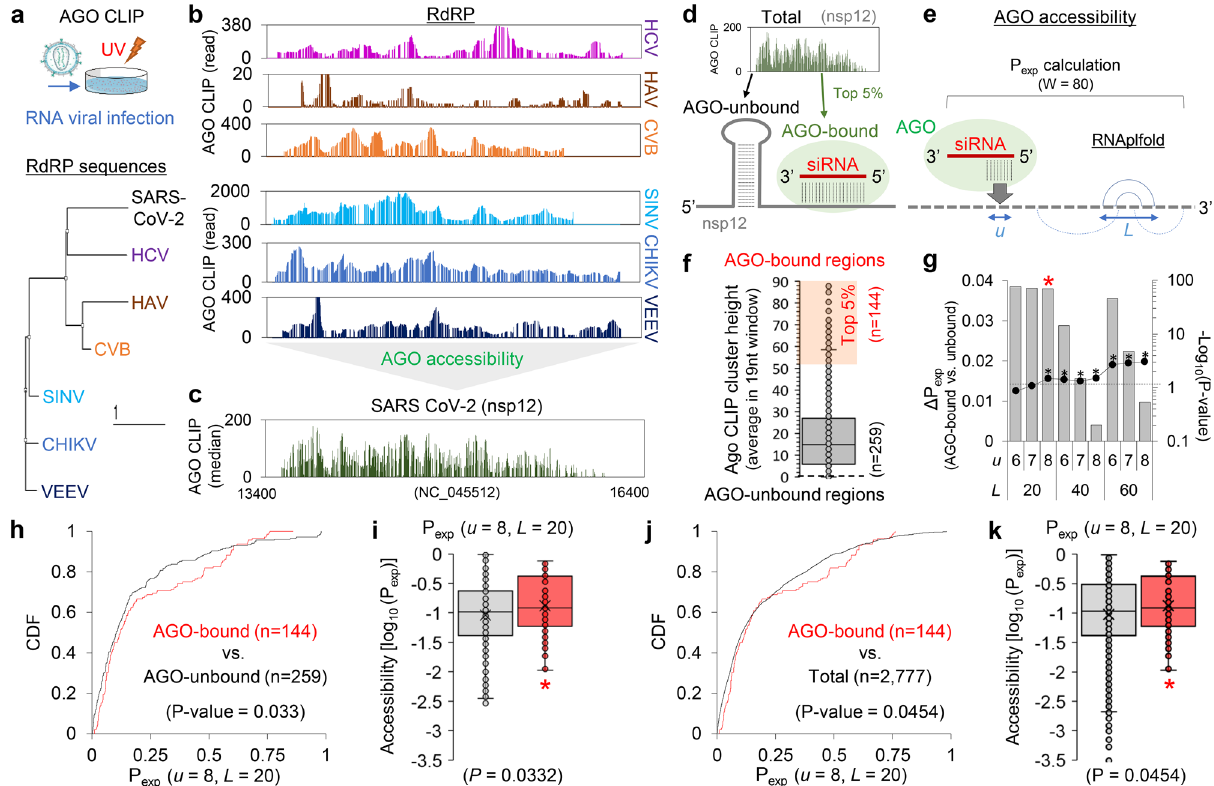
Figure 1. Meta-analyses of AGO CLIP data for SARS-CoV-2 and resultant determination of parameters for calculating AGO accessible regions. ( a ) AGO CLIP analyses derived from various RNA viral infections (upper panel), where published data 29 from standard AGO CLIP were retrieved. Six RNA viruses were selected as related to SARS-CoV-2 based on phylogenic analyses of RdRP sequences (lower panel). Details in the Material and methods section, providing accession numbers in the GEO database. ( b ) AGO-bound regions in the RdRP of the six RNA viruses related to SARS-CoV-2, aligned on the counterpart region of the nsp12 in SARS-CoV-2; HCV, HAV, and CVB ( b , upper panel) and SINV, CHIKV, and VEEV ( b , lower panel) ( c ) Consensus AGO CLIP reads on the nsp12 of SARS-CoV-2 (NC_045512), delineated from the meta-analysis. Compiled AGO CLIP reads (median of read-counts at each position) are presented to estimate putative AGO binding in the nsp12 region of SARS-CoV-2, inferred from the six RNA viruses 29 . ( d,e ) Schematics for predicting AGO accessibility; AGO-bound (top 5%) and AGO-unbound (no CLIP reads) regions presumably caused by RNA secondary structure ( d ); calculation of AGO accessibility (P exp ; exposure probability) using the previously defined window size (80 nucleotides; W = 80) under the parameters 31 , length of a region for accessibility ( u ) and range of nucleotides allowing local base pairing ( L ). ( f ) Ranking of the inferred AGO-accessible sites in nsp12. A set of high confident AGO-bound regions (high AGO accessibility) was defined by selecting the top 5% of compiled AGO CLIP clusters depending on their heights (average read-count in the 19 nucleotides window; n = 144, orange shade). AGO-unbound regions were selected as the sites with no AGO CLIP reads across the selected RNA viruses (HCV, HAV, CVB, SINK, CHIKV, and VEEV) or where AGO CLIP reads were observed in only one RNA virus species (biological complexity = 1; n = 259). ( g ) The partition function for all local structures within the window (80 nucleotides) was calculated to derive the exposure probability (P exp ) with RNAplfold 31 . The difference in P exp between the AGO-bound regions and AGO-unbound regions in nsp12 was calculated (ΔP exp , bar graph); significance, − log 10 ( P -value), line graph; dotted-line, P = 0.05; P -value, Wilcoxon rank-sum test (two-sided). ( h ) Cumulative distribution function (CDF) analyses of P exp under the optimised parameter ( u = 8, L = 20) for the AGO-bound vs. AGO-unbound regions; P -values from Kolmogorov–Smirnov test (two- sided). ( i ) Accessibility of the target sites (log 10 (P exp )) was also calculated for the AGO-bound (red box plot) vs. AGO-unbound regions (grey box plot); * P < 0.05, Wilcoxon rank-sum test (two-sided). ( j,k ) Same CDF analyses ( h ) performed in ( f ) and box plot analyses ( i ) performed in ( g ) except that the AGO-bound regions were compared with the total regions in